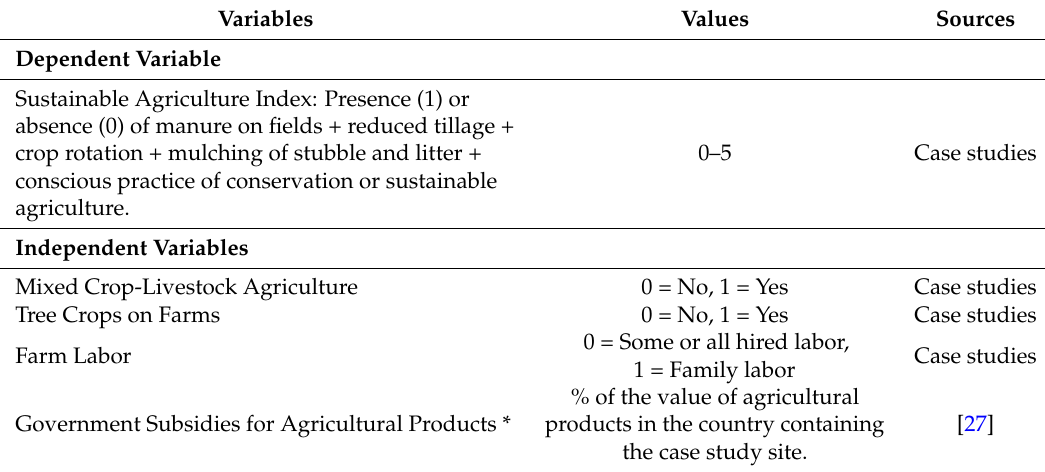
Table 1. Definitions and sources for variables in the multivariate analyses.